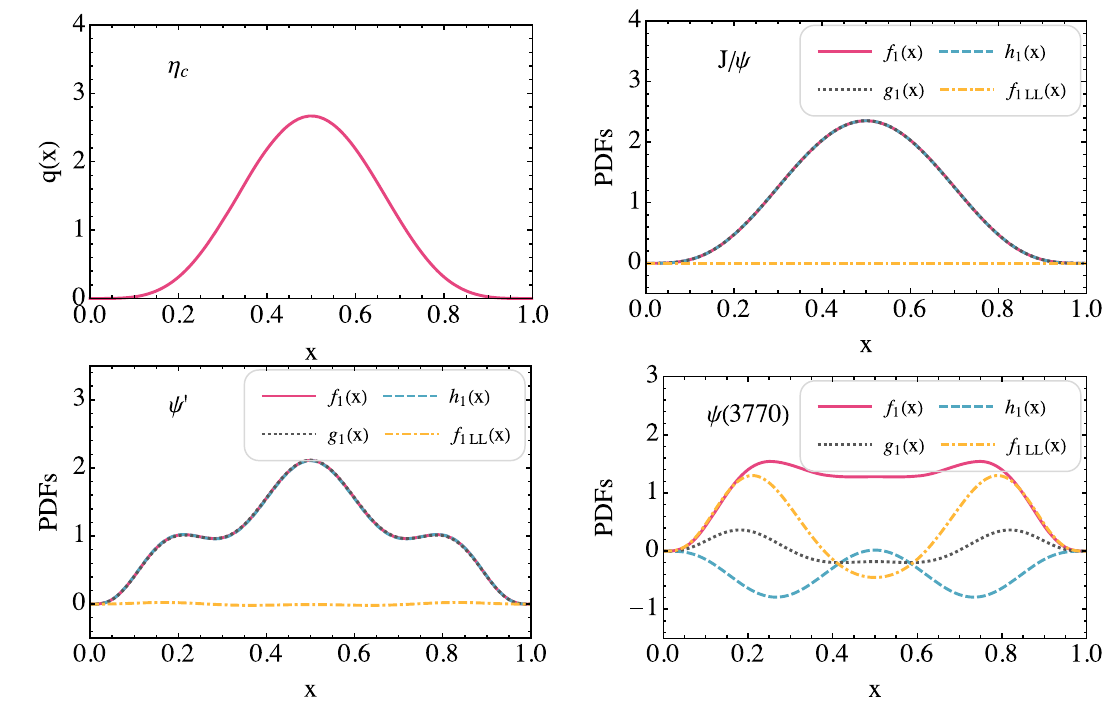
Fig. 11 PDFs of η c , J /ψ , ψ (cid:2) and ψ( 3770 ) , calculated from the constructed LFWFs according to Eq. (56) and Eqs.